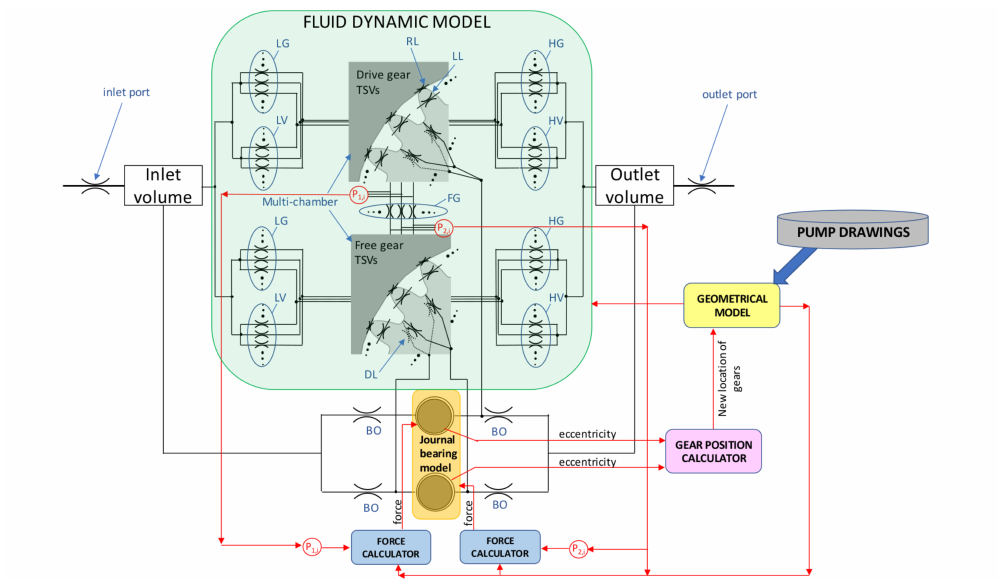
Figure 2. Structure of the simulation tool HYGESim